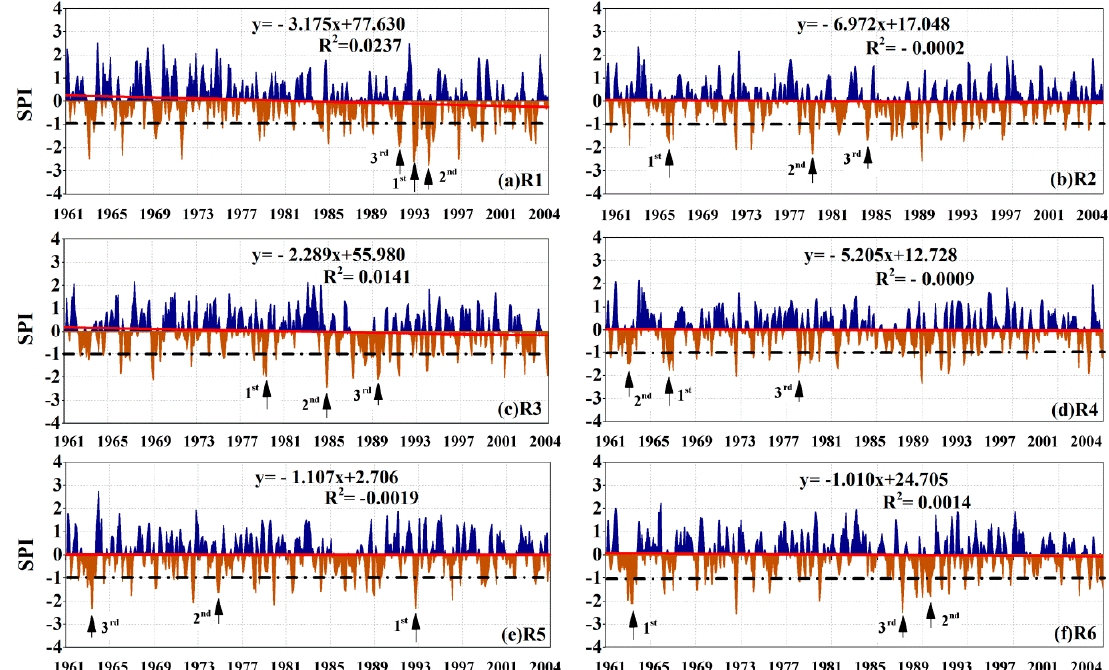
Figure 5. Temporal evolution and trends (red line) of the sub-regional SPI series in six sub-regions (the three most severe drought events ranking first, second, and third are shown with arrows).